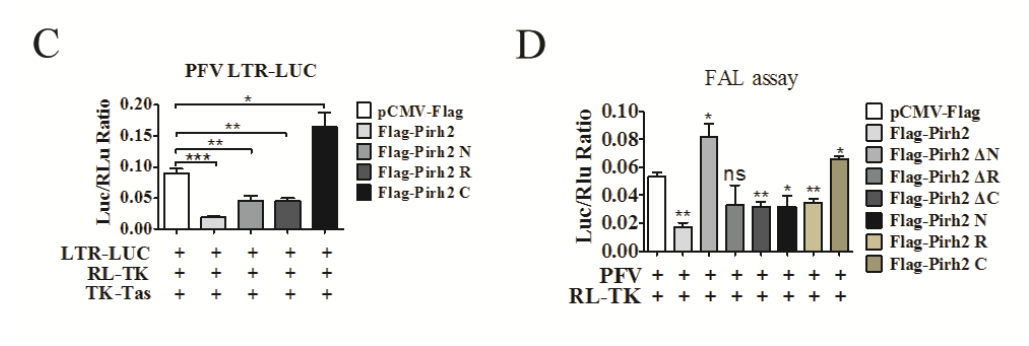
Figure 4. Identification of the key domain of Pirh2 that is responsible for the suppression of PFV. ( A ) Different domains of Pirh2 were cloned into the eukaryotic expression vector pCMV-3Flag; ( B , C ) The influences of Pirh2 ΔN, Pirh2 ΔR, Pirh2 ΔC ( B ) and Pirh2 N, Pirh2 R, Pirh2 C ( C ) on LTR transcription were determined by dual luciferase assay. 293T cells were transfected with LTR-Luc in the presence TK-Tas combined with different truncated Pirh2 plasmids. RL-TK was used to normalize transfection efficiency. At 48 h post transfection, luciferase activities were measured; ( D ) The relative viral load in the presence of different Pirh2 truncations was analyzed using the FAL assay with a PFV indicator cell line. All the data are representative of three independent experiments with triplicate samples. Asterisks denote significant differences of samples compared with the pCMV-Flag transfected